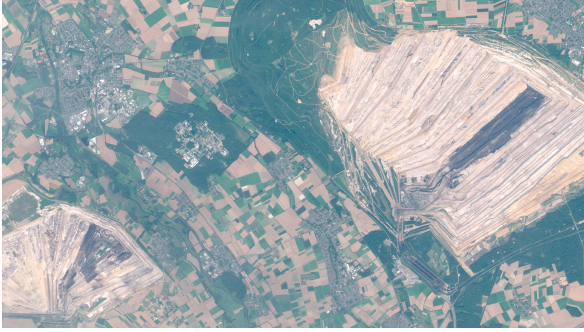
Figure 2: Ortho image of a GeoEye scene, 16 × 9 km